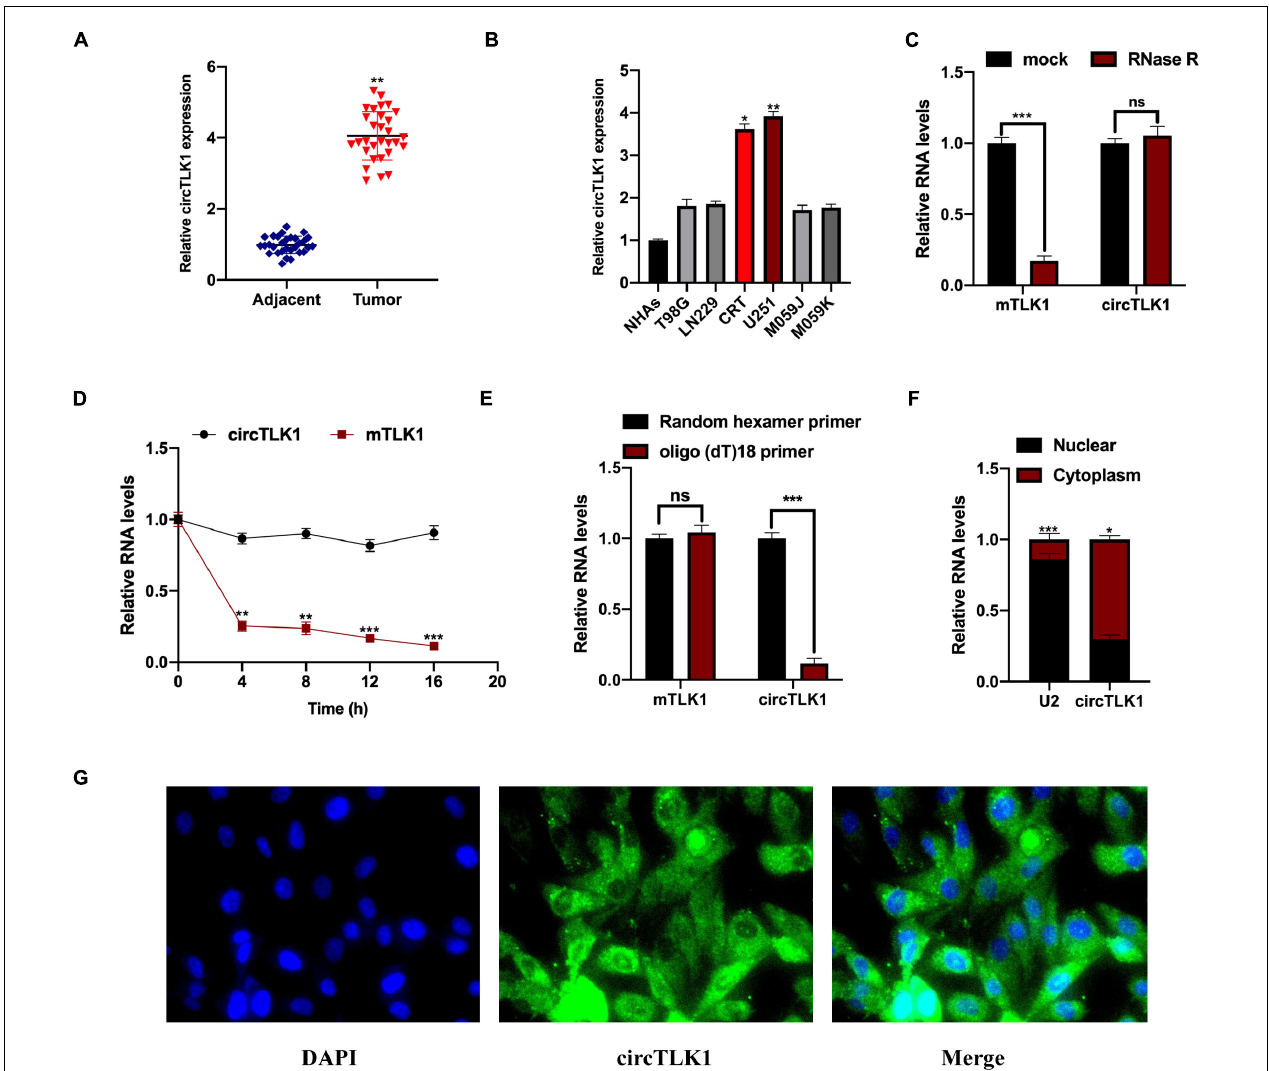
FIGURE 1 | Measurement of circTLK1 in gliomas. (A) Determination of the circTLK1 expression in 30 pairs of glioma tumor tissues and matched normal tissues using qRT-PCR. (B) qRT-PCR was used to measure circTLK1 expression in glioma cells T98G, LN229, CRT, U251, M059J, M059K, and normal human astrocytes NHAs. (C) Relative RNA levels were analyzed using RT-qPCR; the mock group was used for internal normalization. (D) U251 cells were treated with the transcription inhibitor actinomycin D to evaluate mTLK1 and circTLK1 stability. (E) Relative RNA levels analyzed using RT-qPCR in U251 cells; random hexamer primers were used for internal normalization. (F) The level of circTLK1 in the nuclear and cytoplasm of NHAs was measured using a nuclear-cytoplasmic fractionation assay. (G) FISH analysis was conducted to detect the distribution of circTLK1 in NHAs. *p < 0.05, **p < 0.01, ***p <